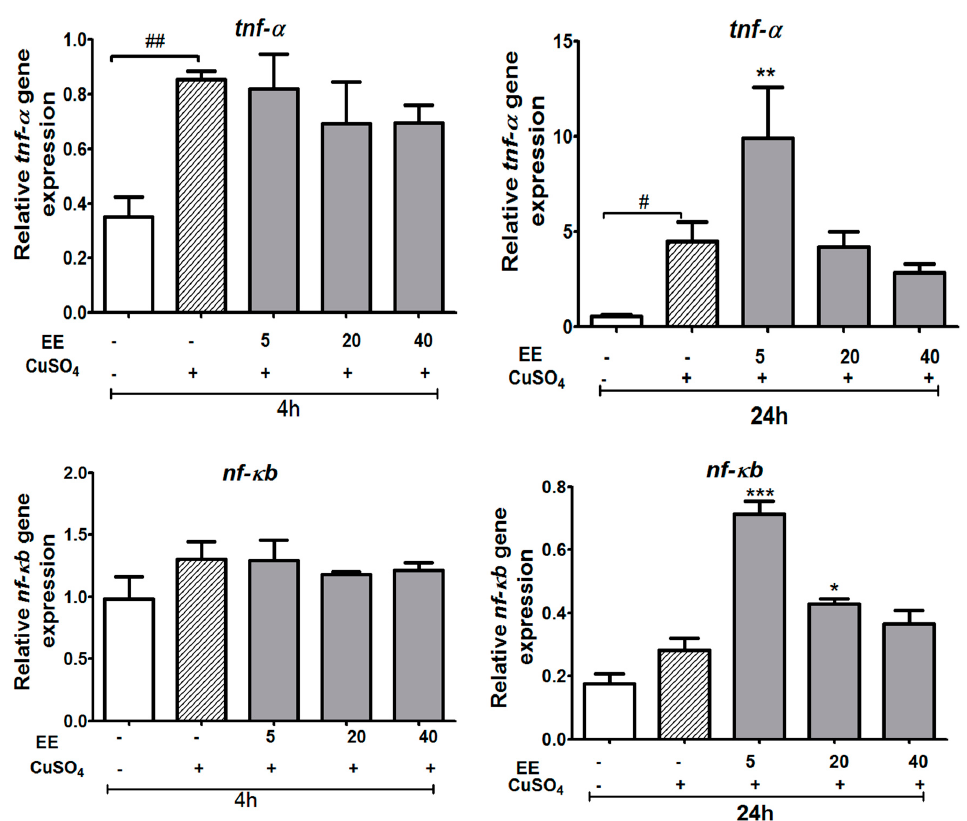
Figure 7. Relative expression of genes involved in immune responses ( tnf- α and nf-